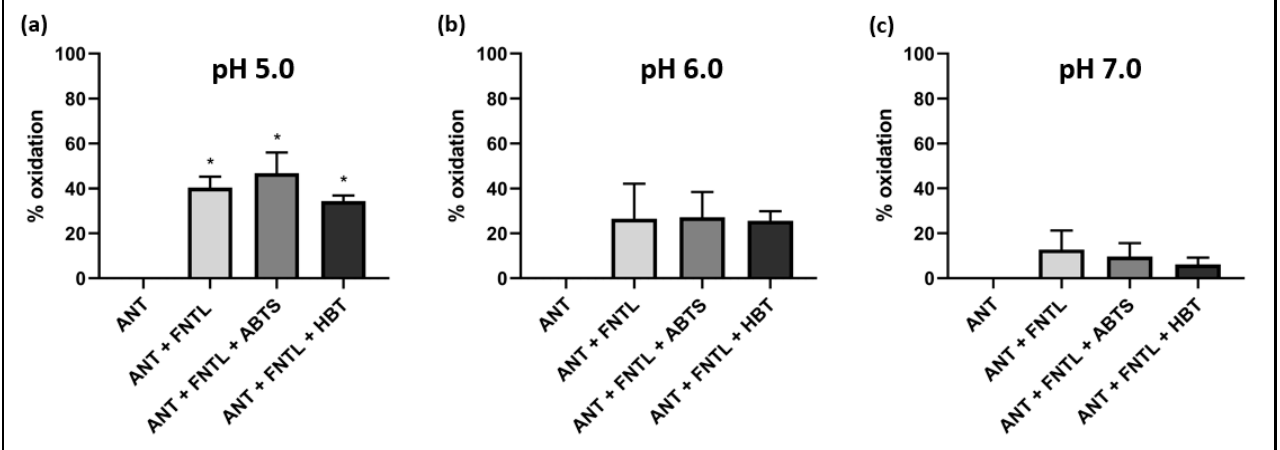
Figure 4. Oxidation of anthracene in the presence of FNTL at three di ff erent pH. ( a ) pH 5.0, ( b ) pH 6.0, and ( c ) pH 7.0. Anthracene (0.05 mg mL − 1 ) was exposed to partially puri fi ed FNTL (0.5 mg mL − 1 ) and 2 mM redox mediator molecules ABTS and AS. Reactions were incubated for 8 days at 40 °C with shaking at 150 rev min − 1 , with enzyme re fi ll at the 3 rd day. The signi fi cant di ff erences were determined using one-way ANOVA, followed by multiple comparisons between the treatments and control using Dunne tt ’s test, indicated as * = p < 0.05.